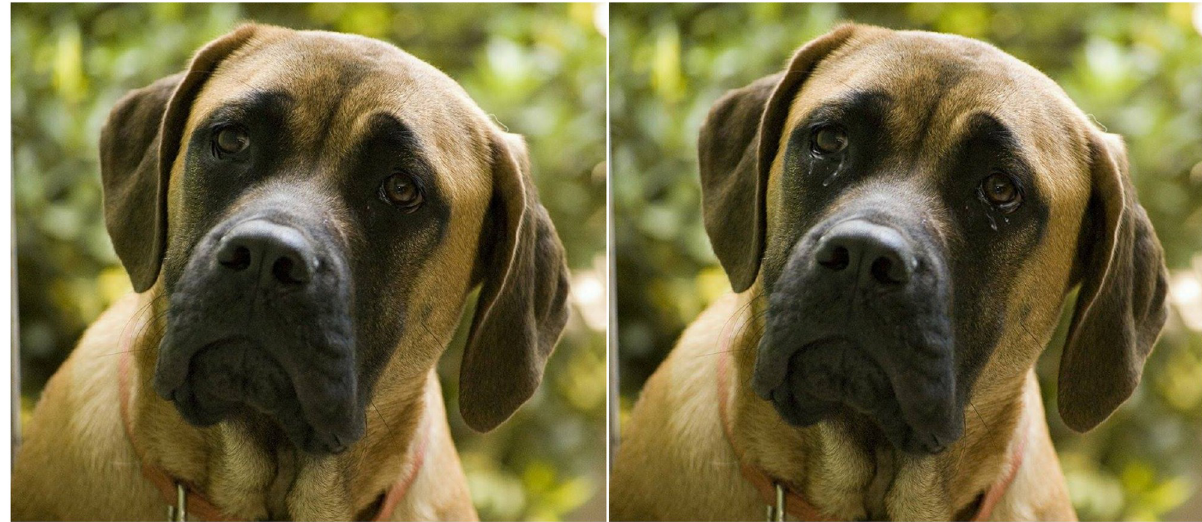
Fig 1. The original photograph of a dog’s face and its tearful